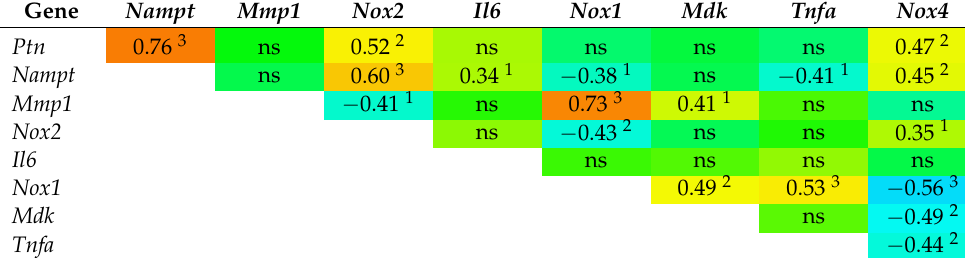
Table 3. Interrelationships between expression of analyzed inflammation-related genes.